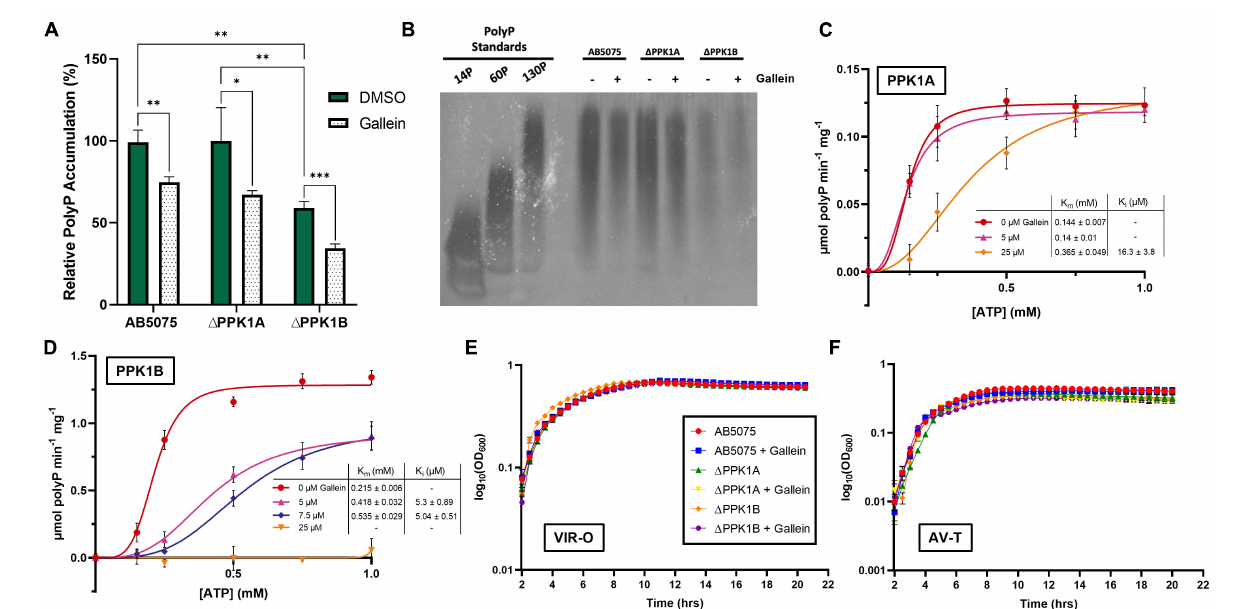
FIGURE 2 | Gallein inhibits A. baumannii PPK1s in vitro and intracellularly but does not attenuate growth kinetics (A) Effect of gallein treatment on starvation-induced intracellular polyP accumulation (B) Bacterial polyP extracts treated with 100 µ M gallein or DMSO vehicle analyzed via electrophoresis on Tris-borate-EDTA (TBE)-urea gel following negative DAPI staining. Image is representative of n = 3 gels. (C,D) Enzyme kinetic analysis of PPK1A (C) and PPK1B (D) . Units are reported in specific activity ( µ mol per min per mg PPK). Curves fit using sigmoidal model (V o = Vmax*[S]ˆh/(K m ˆ h + [S]ˆh), where S is substrate, and h is the Hill coefficient). (E,F) Growth kinetics in lysogeny broth of VIR-O (E) and AV-T (F) phase-variants in the presence or absence of gallein. Symbols are as follows: p > 0.05; ∗ p < 0.05; ∗∗ p < 0.01; ∗∗∗ p < 0.001 (two-way ANOVA, Tukey’s multiple-comparison test, n = 3). All data points are the average from triplicates; error bars are ± SD.